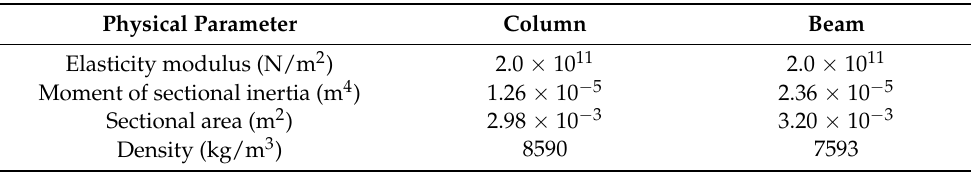
Figure 4. Finite element model of rigid frame. Table 3. Physical parameters of rigid frame structure.